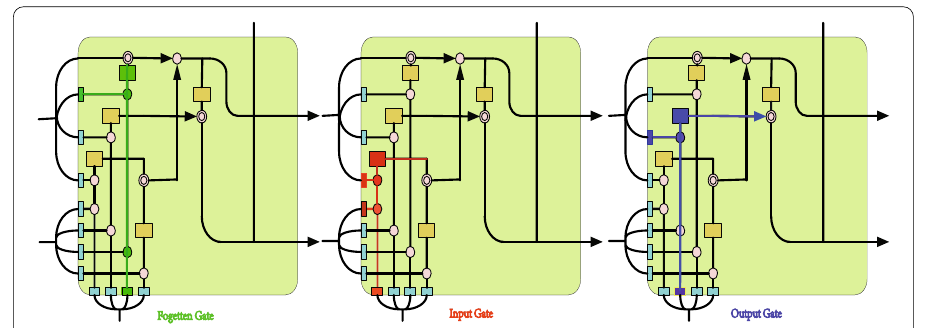
Fig. 12 Main components of Conv2D LSTM